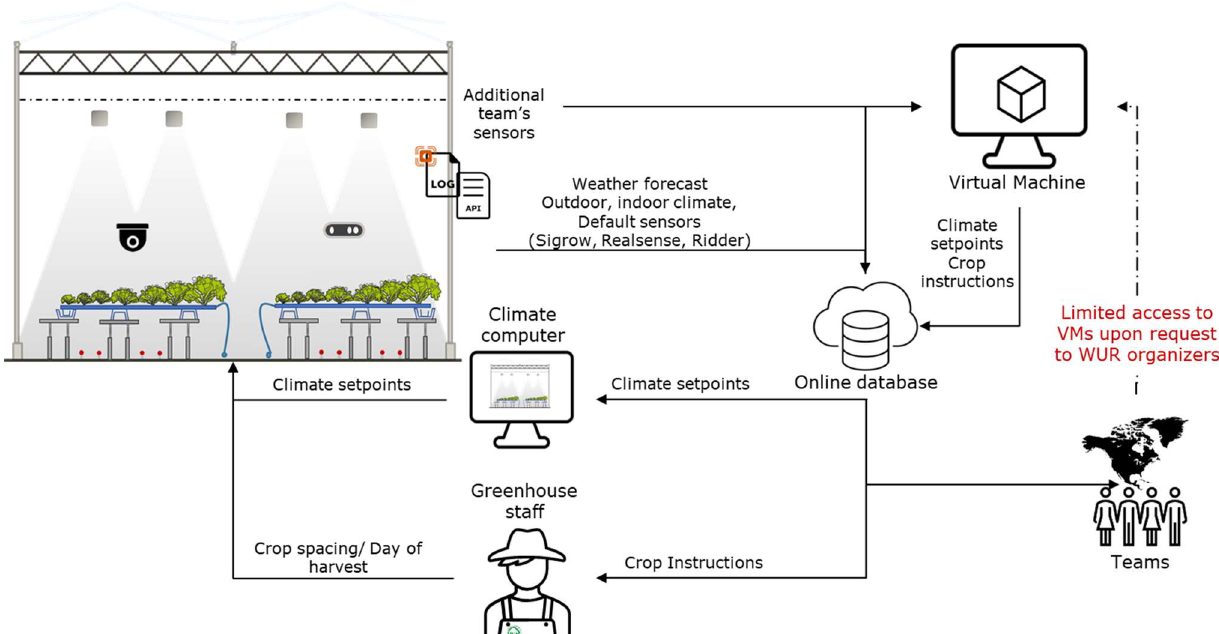
Figure 3. Data communication structure Data flows from indoor and outdoor climate and additional sensors to the virtual machines and the online database. Decisions of algorithms of teams are written from the Virtual Machines to the online database from where another communication protocol writes the controls to the greenhouse climate computer before their implementation in the actual greenhouse compartments. Greenhouse staff receives decisions from online database for spacing and moment of harvest.